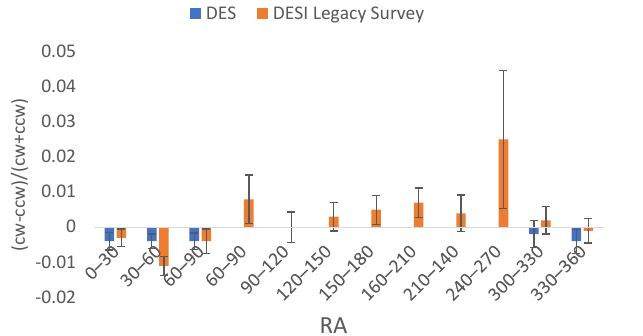
Figure 9. Asymmetry in different 30° RA slices such that the galaxy images are mirrored. The asym- metry is inverse to the asymmetry observed with the original images shown in Figure